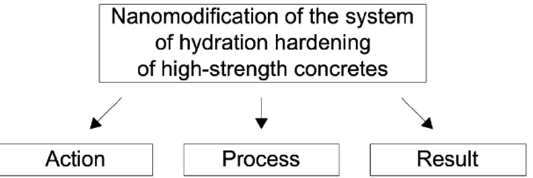
Figure 10. Aspects of nano-modification of hydration-hardening systems for high-strength con- cretes.